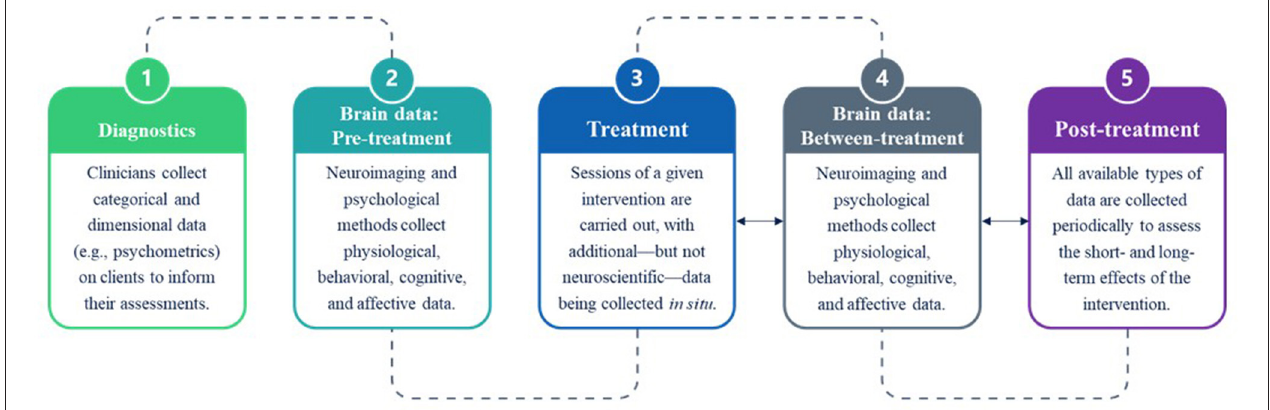
FIGURE 1 | Data collection in the clinical neuroscience of mental health interventions. After an initial evaluation period (1), paradigms investigating the periodic effects of treatment (3) on the brain typically collect data from clinical populations before treatment commences (2), between particular stages of treatment (4), such as at 6 weeks, and at short- and long-term stages subsequent to treatment (5), such as after 14 weeks. Note that no neuroscientific data are collected during the interpersonal interactions driving the treatment sessions, leaving an explanatory gap regarding the nature of the information-processing systems in the brains of both clinicians and clients that contribute to the observed effects of interventions (e.g., cognitive change, emotion regulation, functional connectivity,